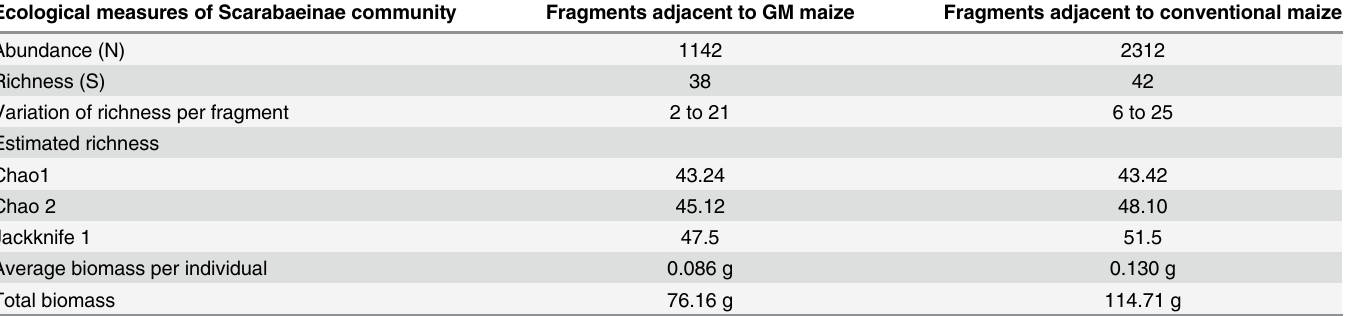
Table 1. Abundance, observed richness, richness estimators Chao 1, Chao 2 and Jackknife 1, mean biomass per fragment, and total biomass cal- culated for the communities of Scarabaeinae beetles in fragments adjacent to GM and conventional maize in Campos Novos, Santa Catarina state,